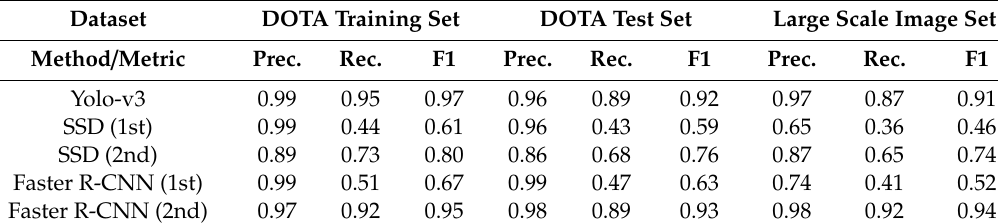
Table 6. Precision, recall, and F1 score of all datasets.